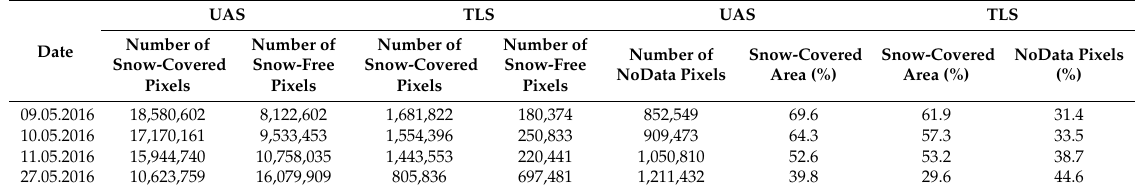
Table 4. Classification results of orthophotos and areal change in snow cover.